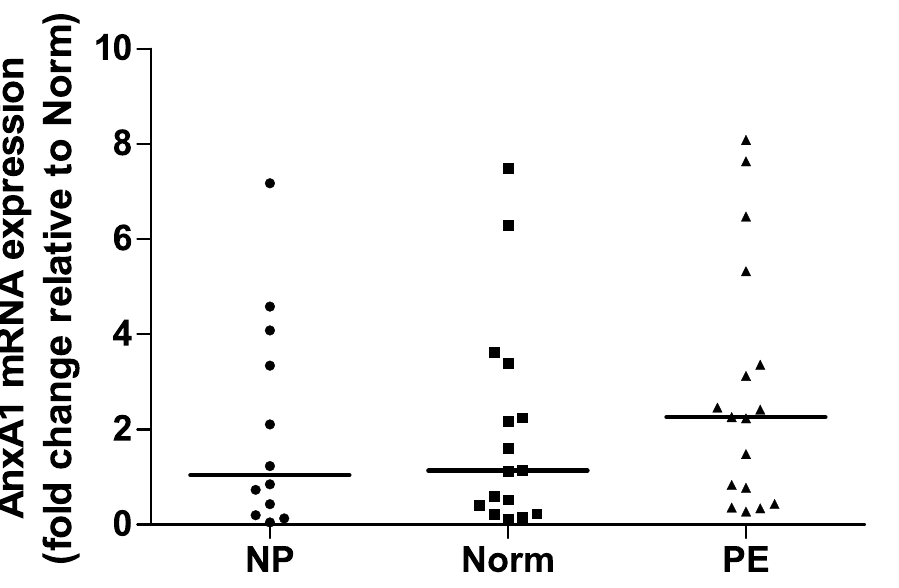
Fig 3. AnxA1 mRNA expression in PBMC of non-pregnant, normotensive pregnant and PE women. NP (non-pregnant women), Norm (normotensive pregnant women), PE (preeclamptic women). Horizontal bars represent median values for Anx1 mRNA fold change expression relative to the calibrator group (Norm). The transcript levels of AnxA1 were similar among the study groups.